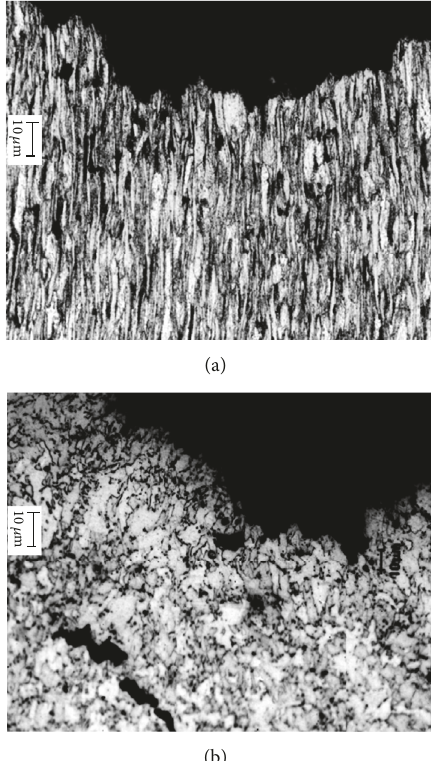
Figure 8: Close to fracture microstructure. (a) C16E after creep exposition at 450 ∘ C, 7120 h; (b) H300LAD after creep exposition at 450 ∘ C, 8930